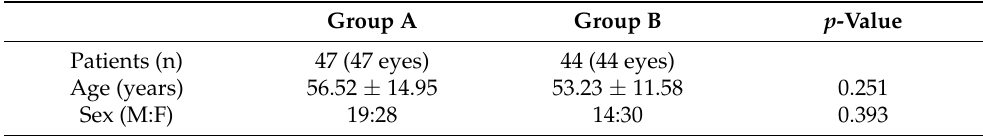
Table 1. Demographics of the patients in each group. Group A Group B p -Value